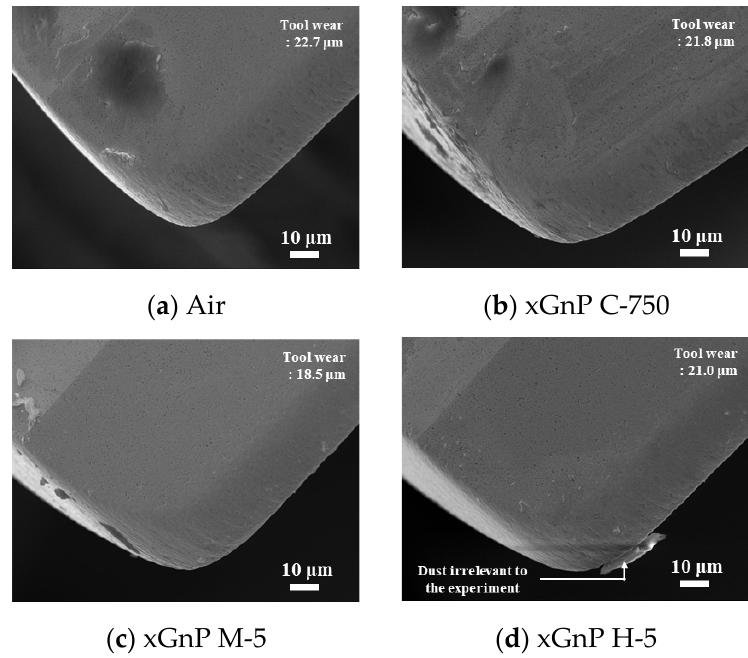
Figure 18. FE-SEM images of tool flank after drilling 92 holes (× 1000)